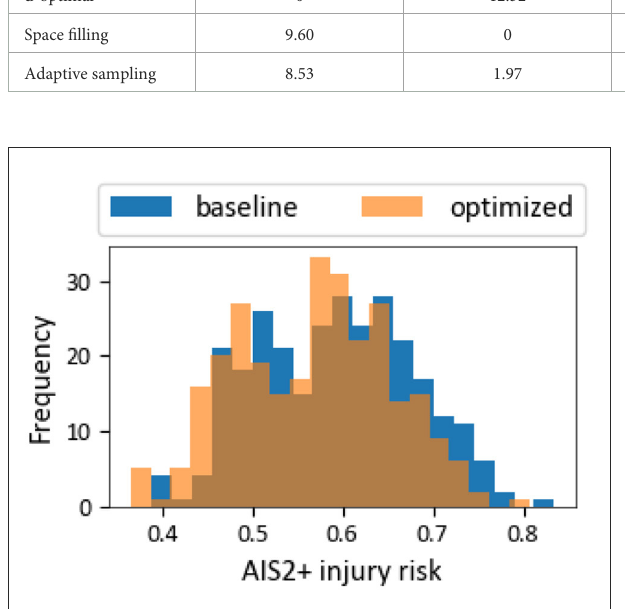
FIGURE13 Predicted joint AIS2 injury risk distribution with standard and + optimized restraint system parameters.